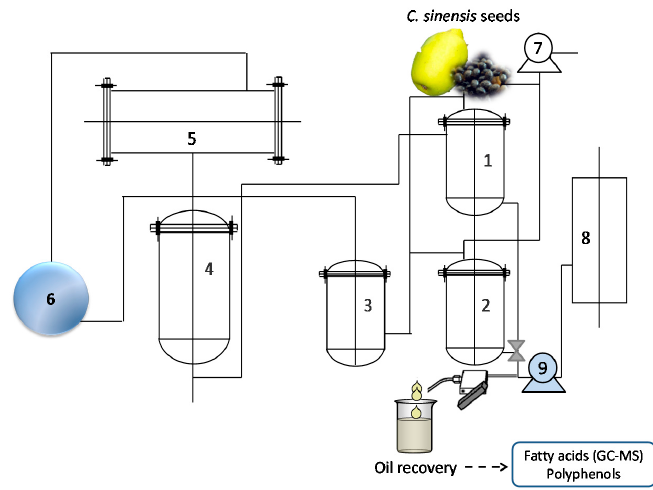
Figure 4. Schematic diagram of the subcritical fluid extraction (SbFE) apparatus and the extraction process followed to recover oil and high-added value compounds from C. sinensis seeds. (1) extraction pot; (2) separation pot; (3) surge pot; (4) n-butane storage pot; (5) condenser; (6) compressor; (7) vacuum pump; (8) hot water cylinder; (9) hot water pump.